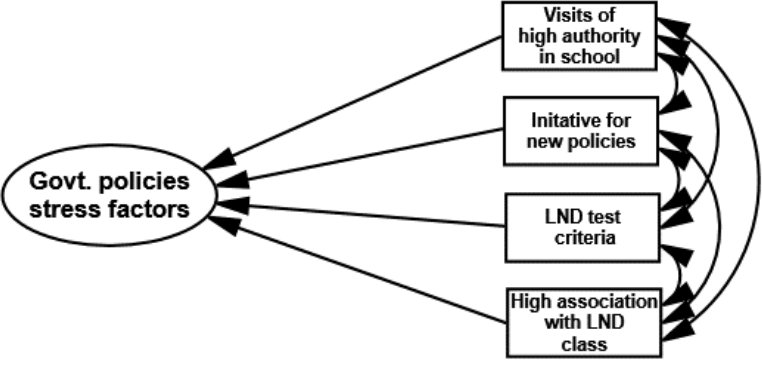
Figure 13. Hypothetical model of government policies.